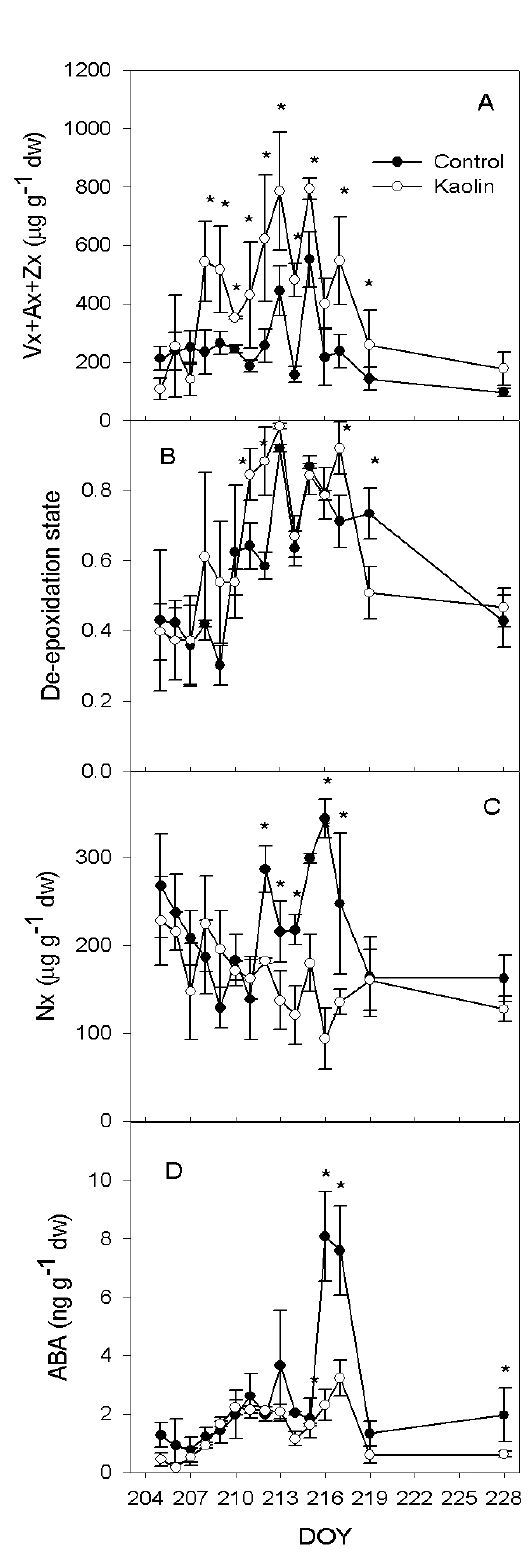
Figure 3. ( A ) Trends for leaf violaxanthin (Vx) + antheraxanthin (Ax) + zeaxanthin (Zx) content, ( B ) de-epoxidation state, ( C ) neoxanthin (Nx) content and ( D ) abscisic acid (ABA) concentration, according to a progressive water shortage (DOY 209–217) and subsequent re-watering (at DOY 218), in vines subjected to the kaolin treatment and in controls. Bars represents standard error, n = 3. Asterisks indicate dates within which di ff erences among treatment were significant ( p < 0.05). DOY: day of the